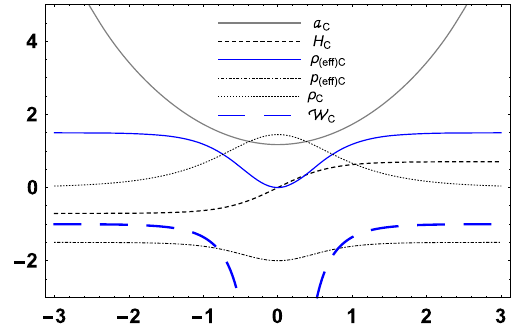
Fig. 5 The cosmological quantities related to the bouncing solution of the model C for, n = 3, a 0 = 1 . 3 ρ 0 = 2, (cid:14) C = 3, α = 1 and Q = 0 .